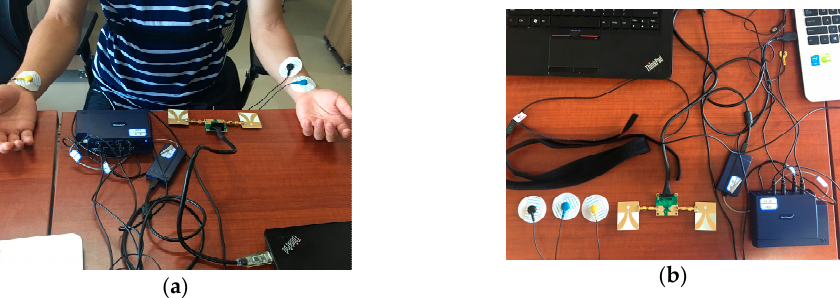
Figure 9. Experimental setup. ( a ) Experimental scenario; ( b ) the radar sensor and DynaMap Suite. Table 1. Specifications for the measurement.